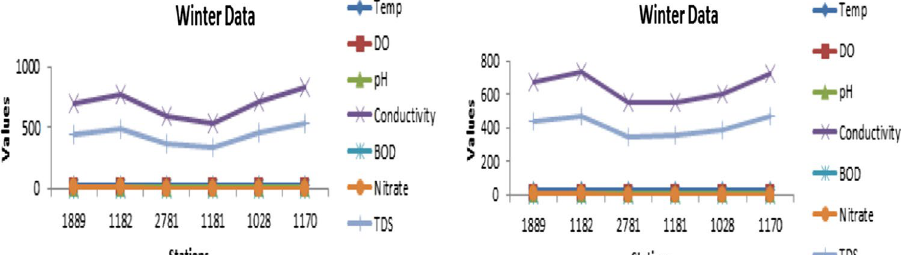
Fig. 9 Yearly variations of different water parameters in winter season for year 2008 and 2016